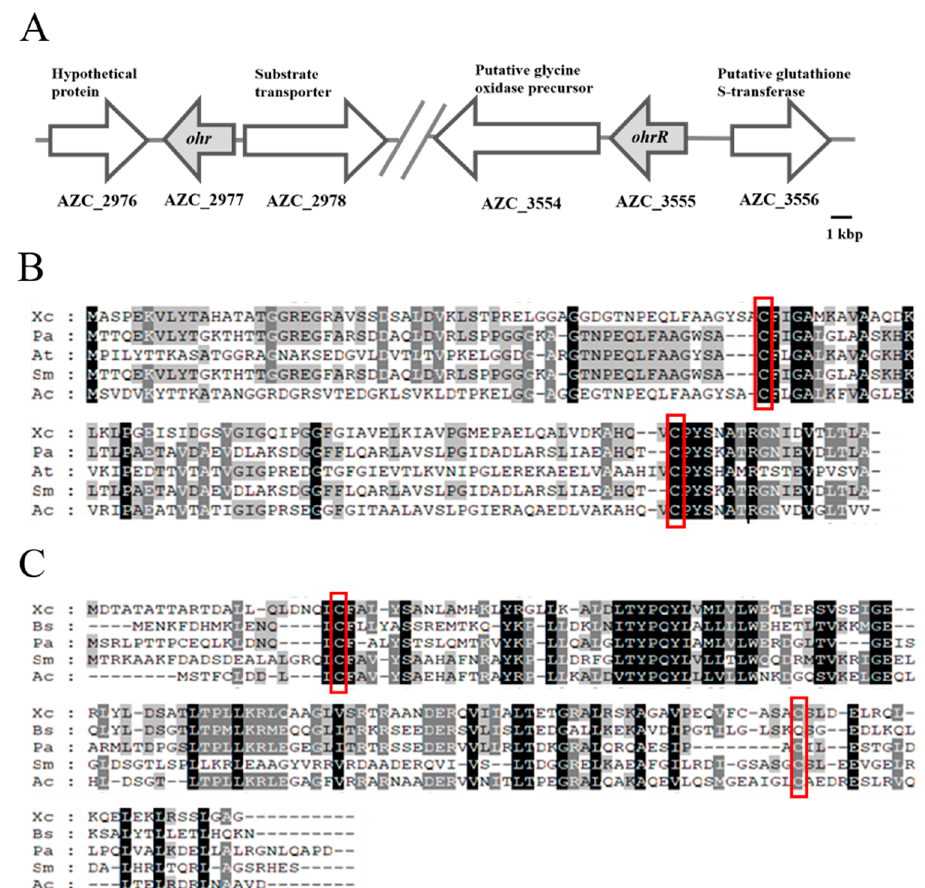
Figure 1. Identification of organic peroxide relevant genes ohr and ohrR in Azorhizobium caulinodans ORS571. ( A ) Genomic organization of the ohr and ohrR region in A. caulinodans ORS571. ( B ) Alignment of the amino acid sequence of Ohr from Xc ( Xanthomonas campestris ), Pa ( Pseudomonas aeruginosa ), At ( Agrobacterium tumefaciens ), Sm ( Sinorhizobium meliloti ), and Ac ( Azorhizobium caulinodans ORS571). ( C ) Alignment of the amino acid sequence of OhrR from Xc , Bs ( Bacillus subtilis ), Pa , Sm, and Ac . Red rectangular boxes indicate conserved cysteine residues.